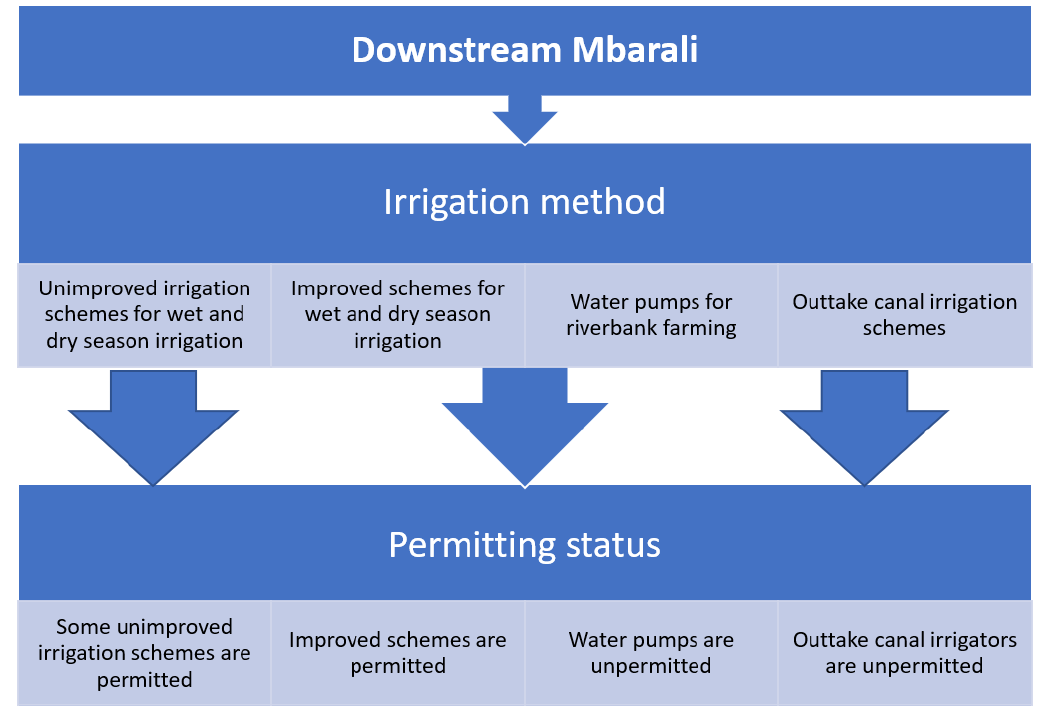
Figure 3. Permitting status by irrigation method in downstream Mbarali. Source: Produced by the author.